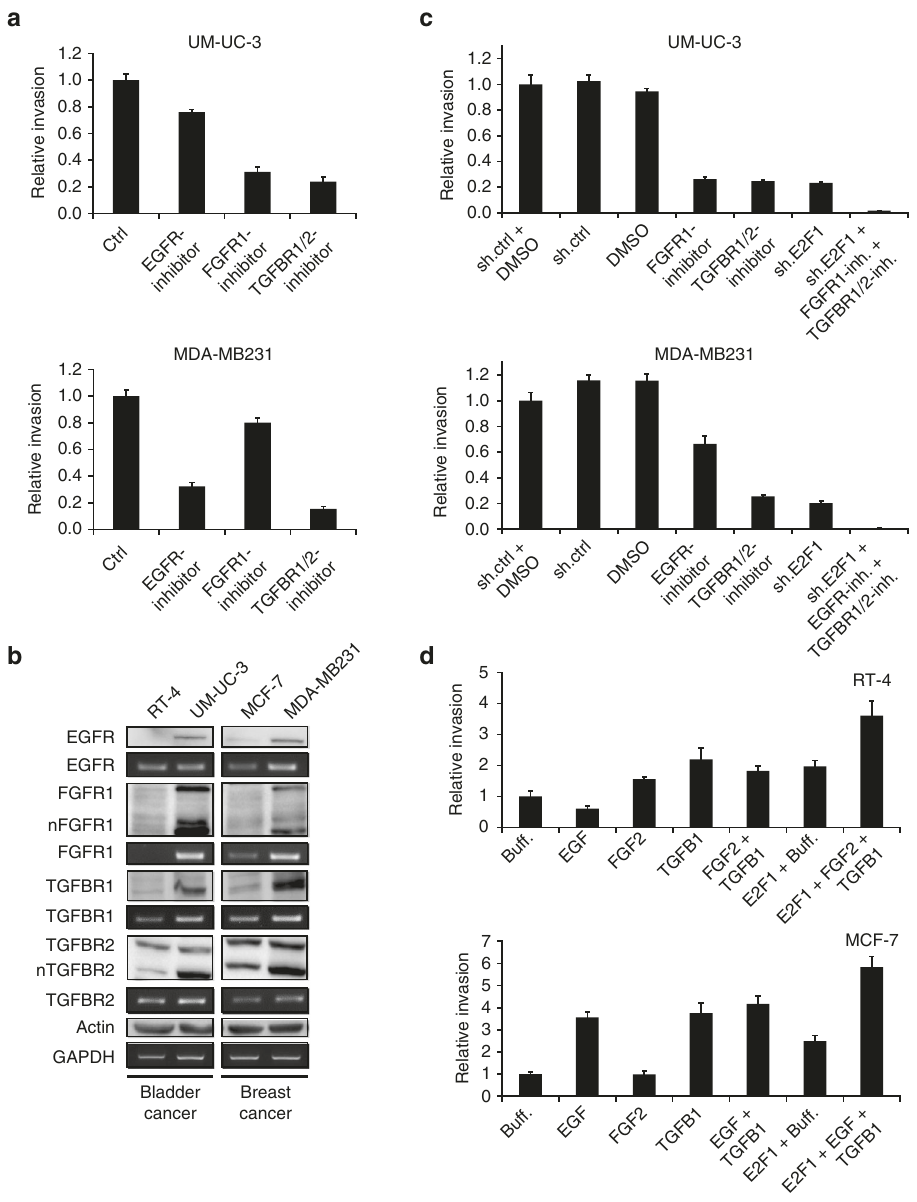
Fig. 5 Effects of the EGFR, FGFR1, and TGFBR pathways on bladder and breast cancer invasion. a Different effects of EGFR inhibitor and FGFR1 inhibitor on invasive bladder (UM-UC-3) and breast cancer (MDA-MB231) cell lines. b Western blots and PCRs show the expression levels of the indicated receptors in less-invasive (RT-4, MCF-7) vs. invasive (UM-UC-3, MDA-MB231) cells. EGFR, FGFR1, as well as TGFBR1 are highly expressed in both invasive cell lines compared to the less-invasive ones. TGFBR2 expression levels equal within cell lines of each tissue type, whereas the nuclear fraction of TGFBR2 (nTGFBR2 as well as nFGFR1 for FGFR1) shows a clear upregulation in both invasive cancer cell lines. c Invasive potential of UM-UC-3 or MDA-MB231 was measured by Boyden chamber assay upon treatment with an E2F1 -speci fi c shRNA and inhibitors for TGFBR1/2, EGFR, or FGFR1 as indicated. d Boyden assay indicating the invasive potential of epithelial cell lines after stimulation with growth factors and/or overexpression of E2F1 transcription factor. Cells were preincubated in growth factor supplemented medium (10 ng/ml of EGF, FGF2, TGFB1, or both) and transduced with adenoviral vector for overexpression of ER-E2F1, which was activated by adding 4-OHT. Fold-changes were calculated relative to control cells (set as 1). All fi gures are representatives of at least three independent experiments. All error bars indicate